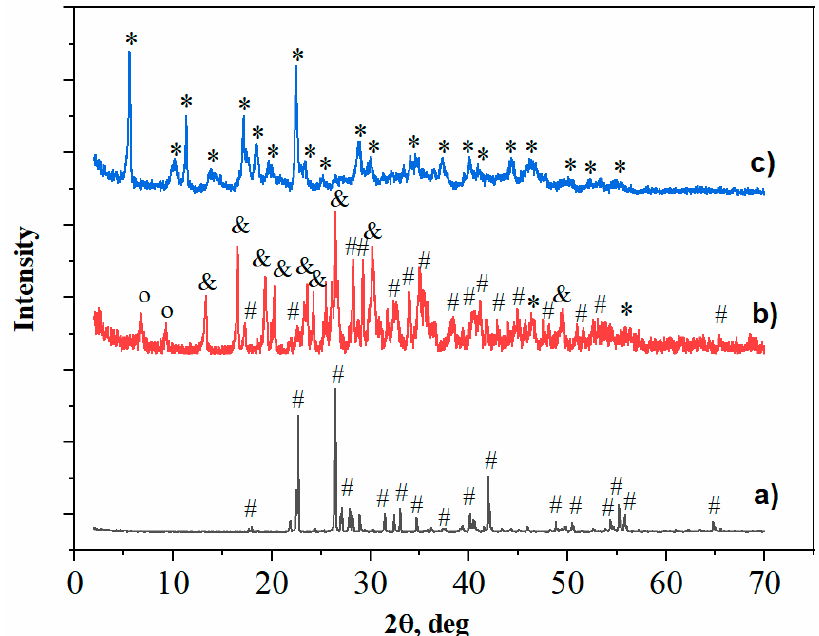
Figure 1. The XRD spectra of the initial components, as follows: sodium dihydrogen phosphate ( a ), calcium citrate tetrahydrate ( c ), and cement-salt stone based on calcium citrate tetrahydrate and sodium dihydrogen phosphate ( b ). Symbols are as follows: #—NaH 2 PO 4 (PDF 70-954); *— Ca 3 (C 6 H 5 O 7 ) 2 · 4H 2 O (PDF 28-2003); o—non-identified reflexes; &—CaHPO 4 (PDF 70-360).